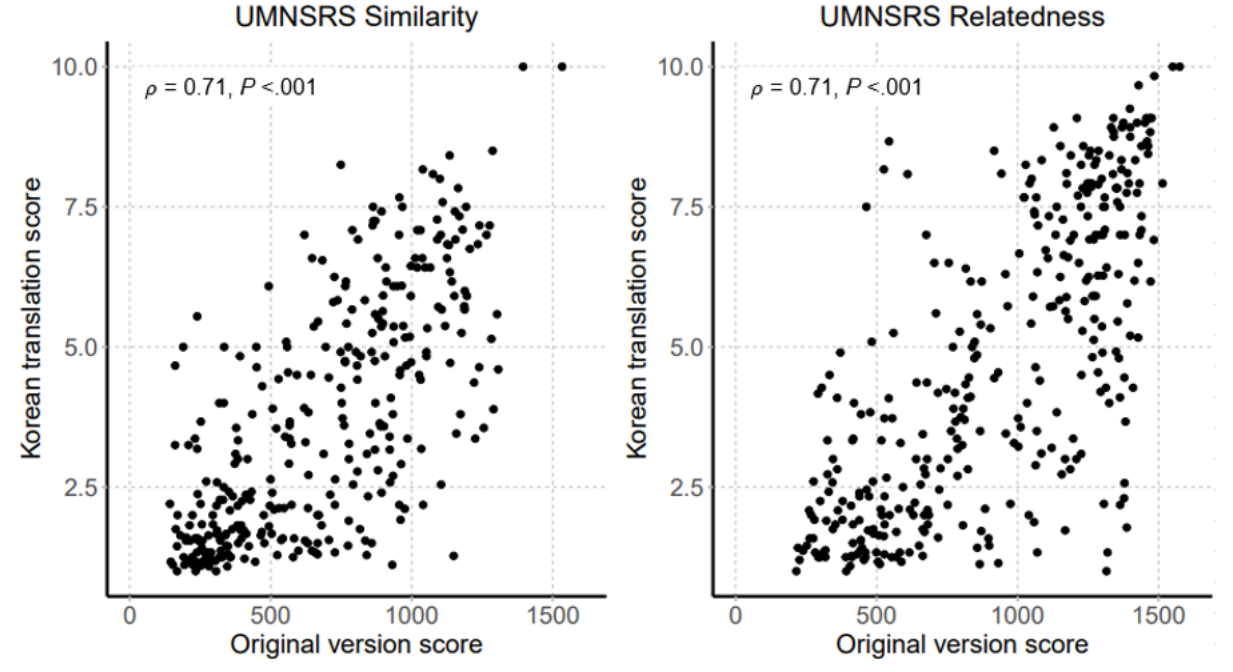
Figure 4. Correlation between the reference scores for the original University of Minnesota Semantic Relatedness Set (UMNSRS) word pair sets (English version) and the scores from 12 health information managers for the Korean translation version.